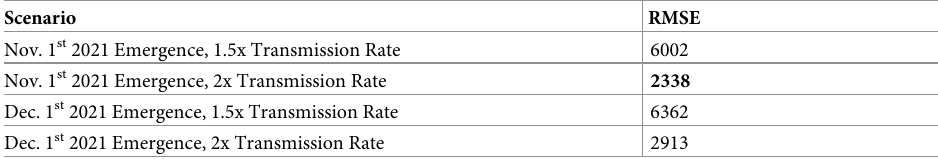
Table 4. RMSE and relative error of various omicron